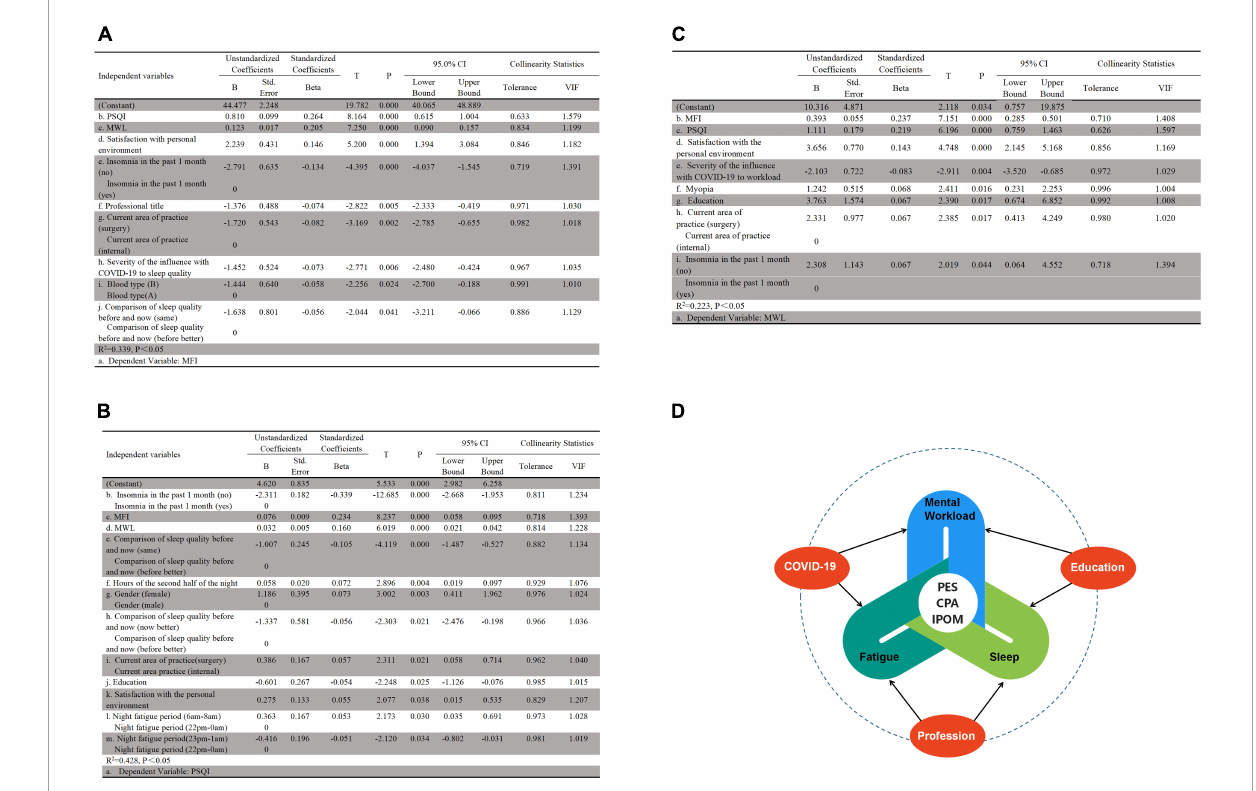
FIGURE4 Stepwise linear regression of the factors associated with the target outcomes ( n = 1004). MFI, multiple fatigue impact scale; PSQI, the Pittsburg Sleep Quality Index; MWL, the NASA task load index; PES, personal environment satisfaction; CAP, current area of practice; IPOM, insomnia in the past one month. (A) Factors associated with MFI. (B) Factors associated with PSQI. (C) Factors associated with MWL. (D) Common influencing factors of MFI, PSQI and